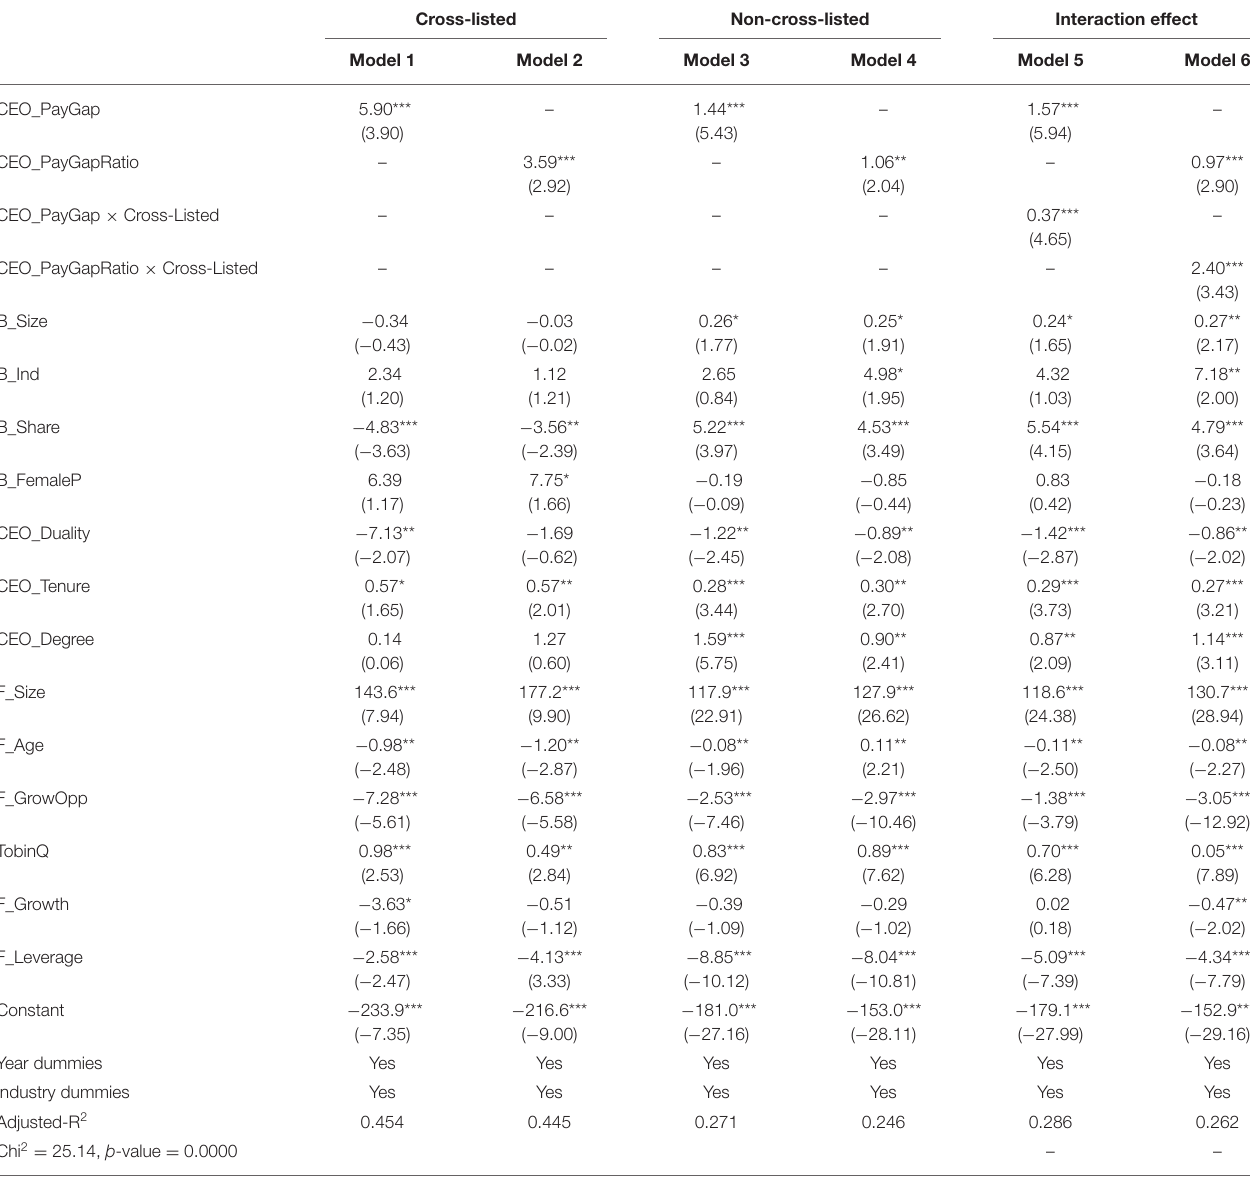
TABLE 4 | CEO tournament incentive and corporate social responsibility performance (sub-sample cross-listed vs. non-cross-listed) and interaction